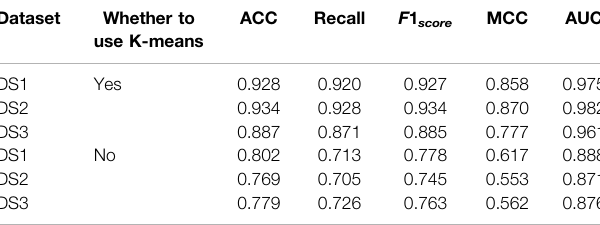
TABLE 5 | Performance comparison without